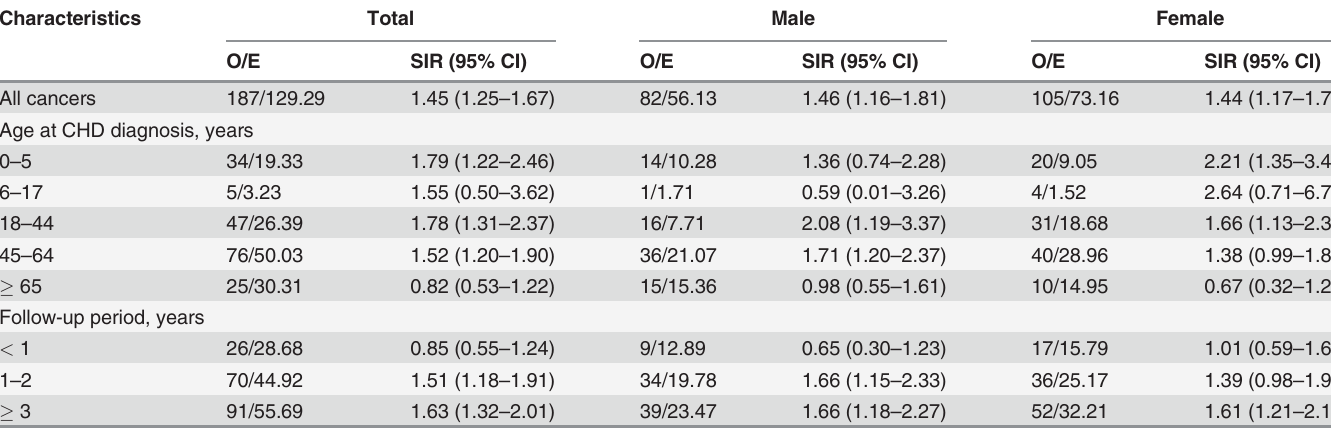
Table 2. Standardized incidence ratios (SIR) for all cancers according to gender, age at CHD diagnosis, and follow-up period. Characteristics